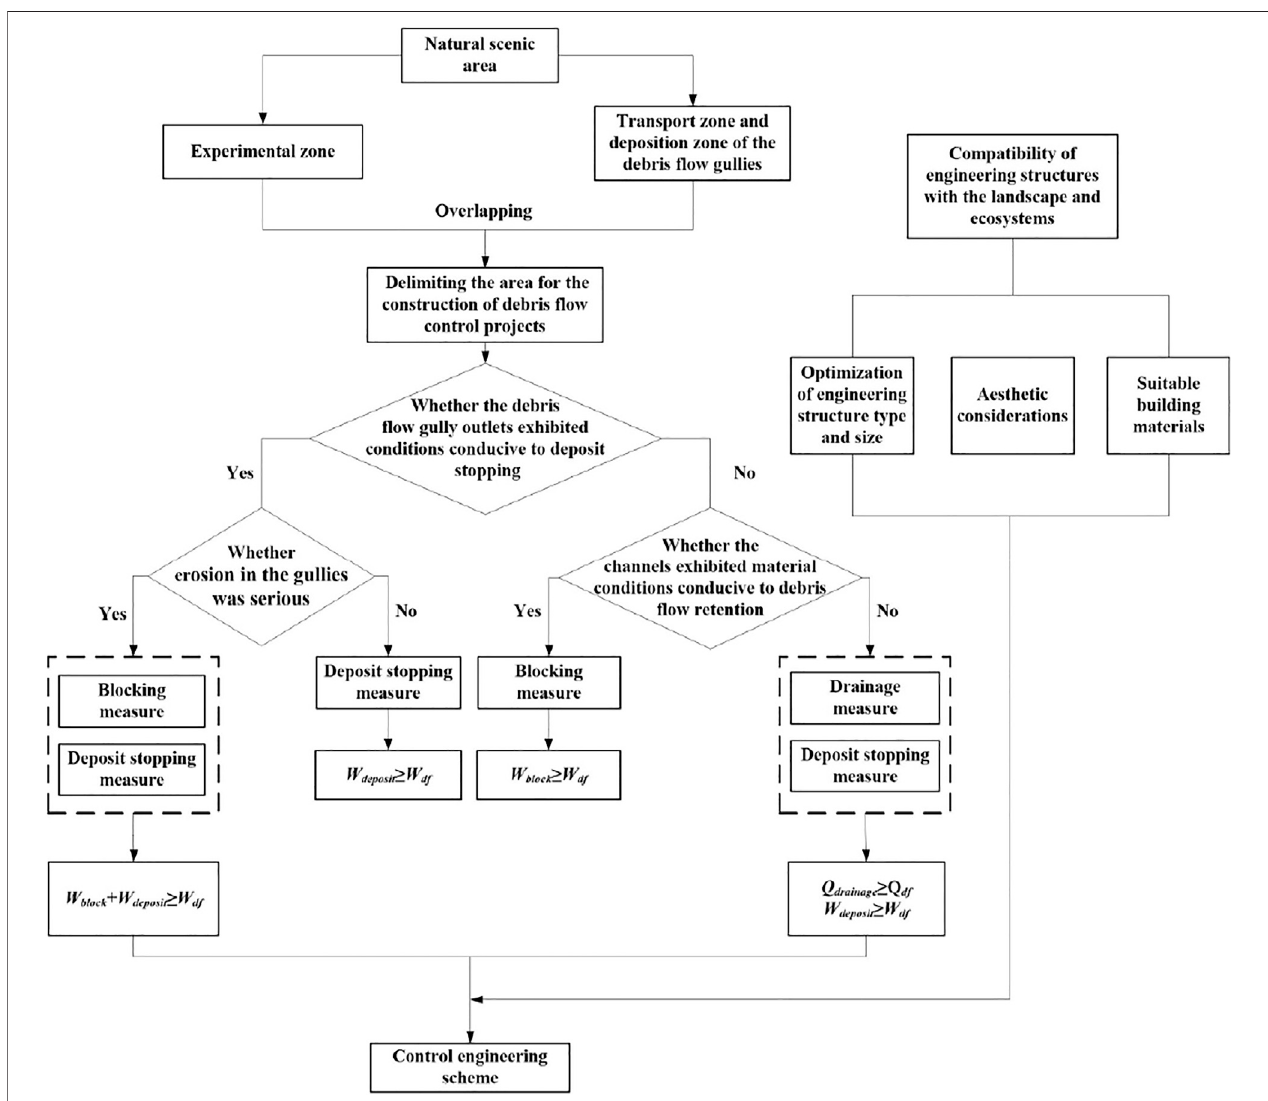
FIGURE 9 | Technical roadmap for planning of debris fl ow control projects in scenic areas.